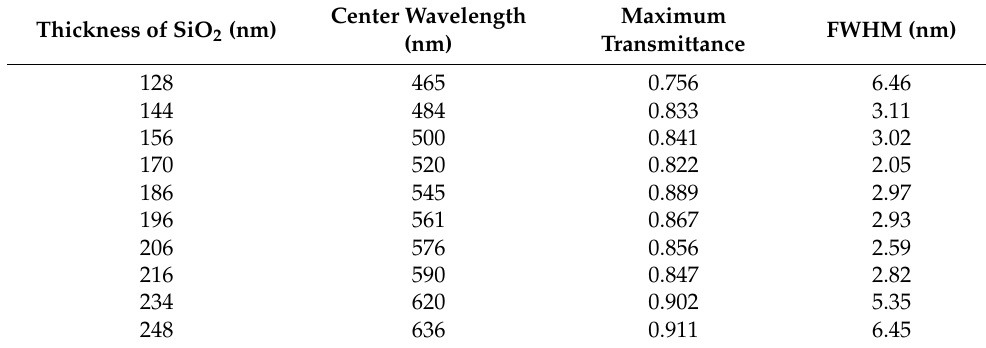
Table 1. The spectral data of the FP cavities with various thicknesses of SiO 2 interlayer.